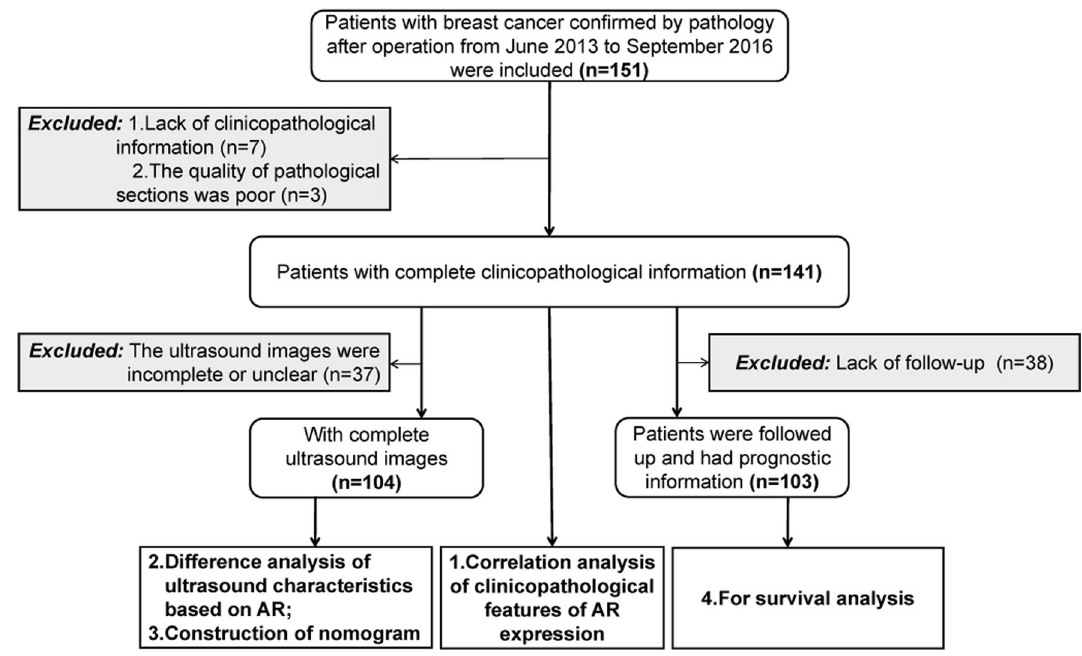
Fig. 1 Flow chart for patient selection. AR , androgen